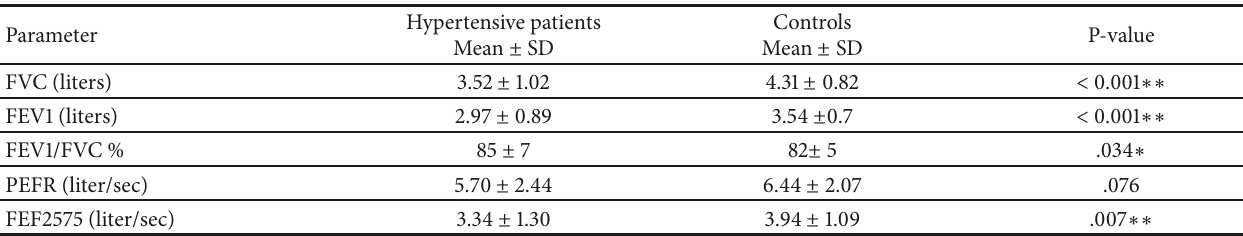
Table 3: Comparison of PFTs in hypertensive patients and controls at Zewditu Memorial Hospital, Addis Ababa, Ethiopia,